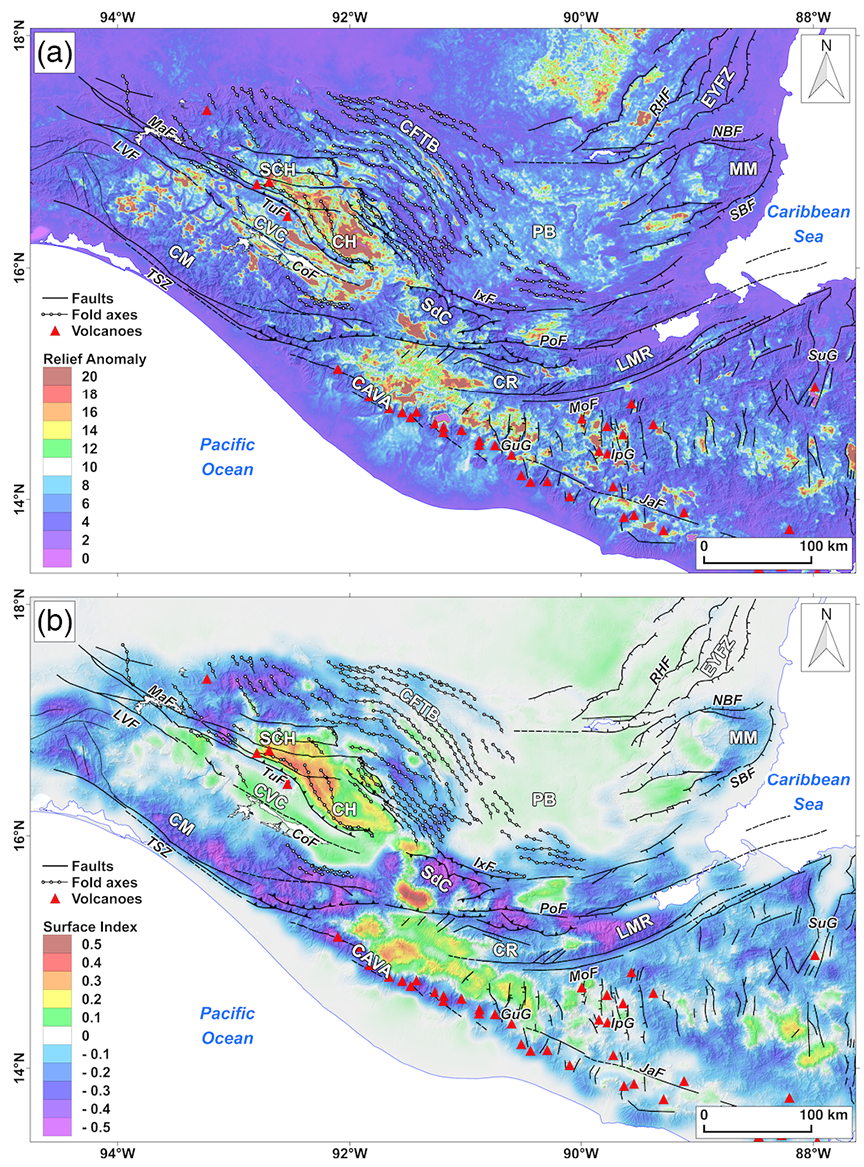
Figure 8. Relief anomaly (a) and surface index (b) for northern Central America. See Fig. 2 for